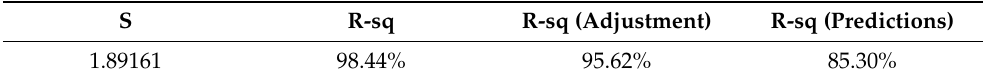
Table 6. Analysis of model for BBD